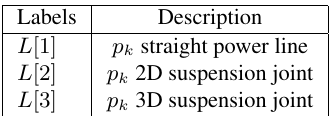
Table 1. Description of labels